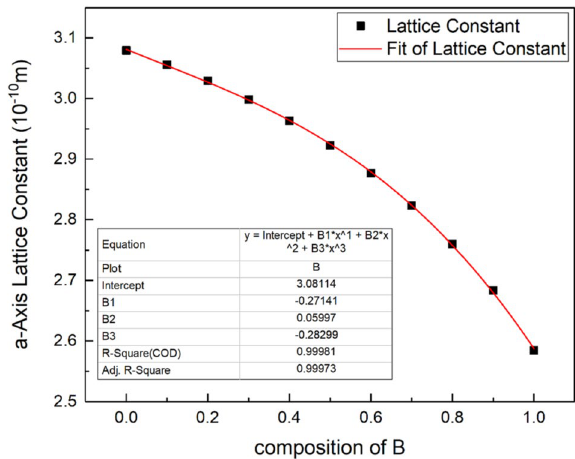
Figure 5. a-Axis lattice constant changing with B